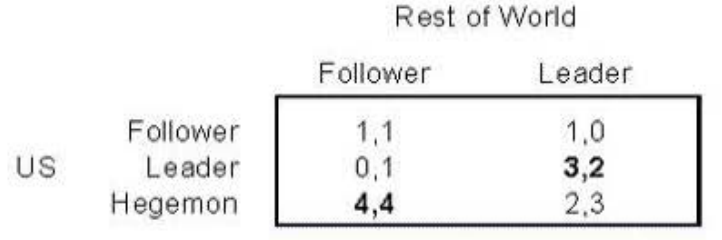
Table 4.3 A simple model of the world political economy , 1945-1950 [Page (iO] Joumal q( World-System, Resmrch